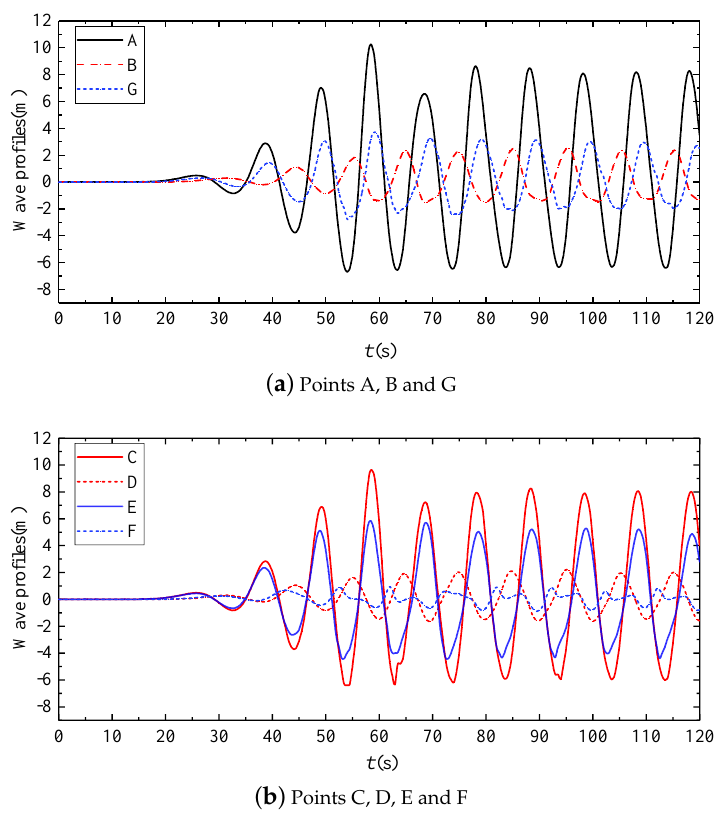
Figure 11. Time histories of wave profiles at seven typical locations around the dumbbell